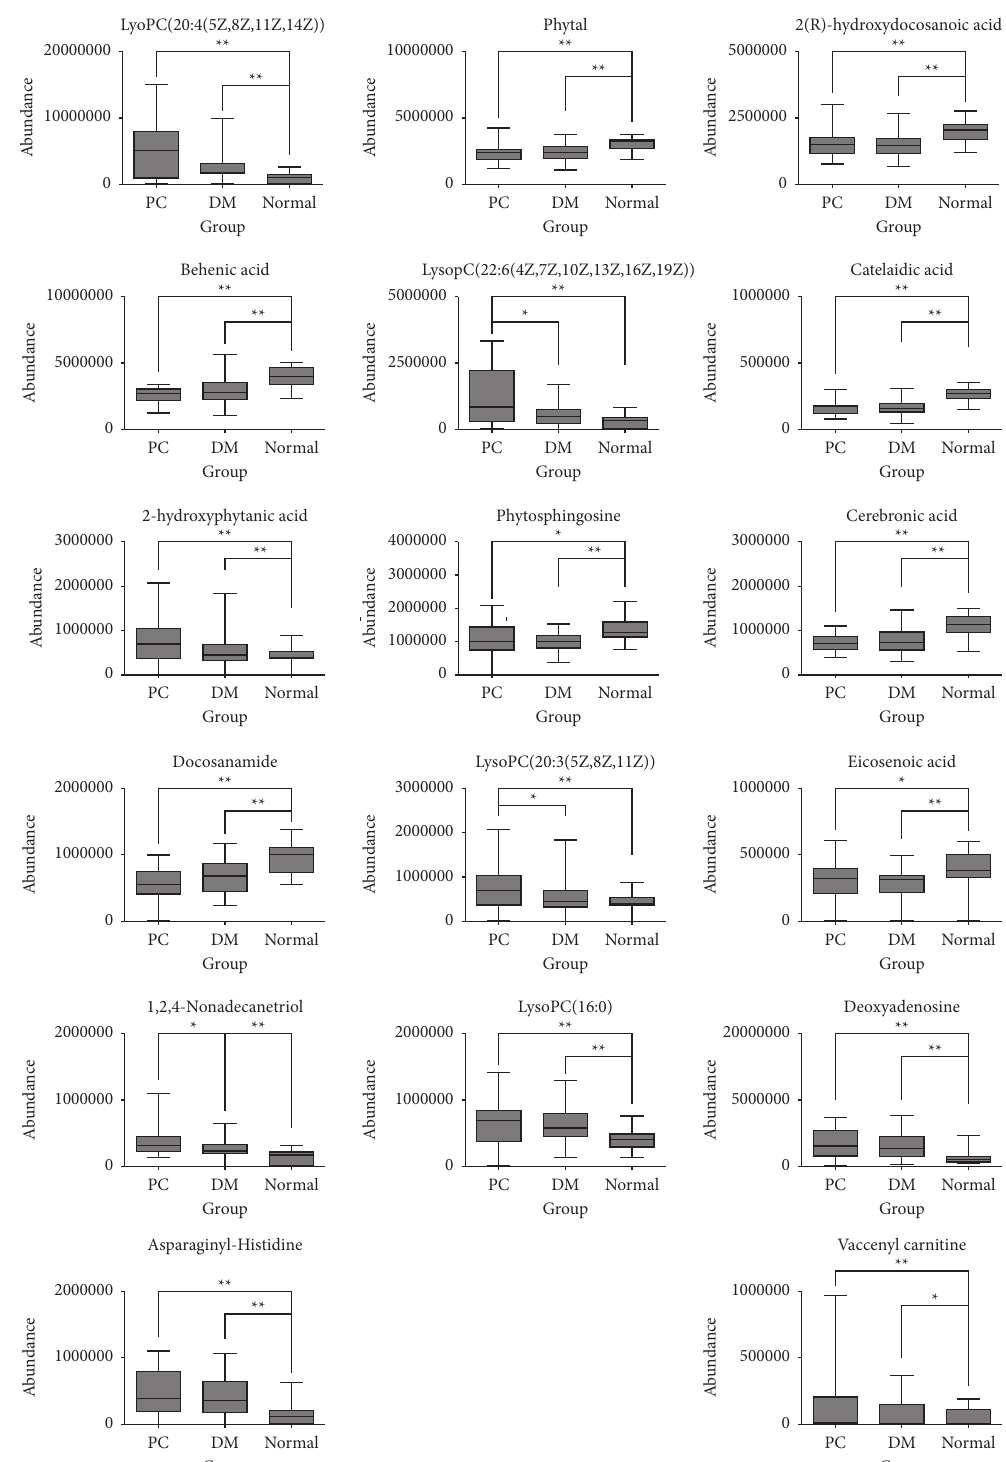
Figure 4: Differential metabolite ions in PC, DM, and normal groups. Mann–Whitney U test: ∗ P 0 . 05; ∗∗ P 0 . 01. These results suggest the importance of differential metabolite ions we screened and identified for differentiating PC and